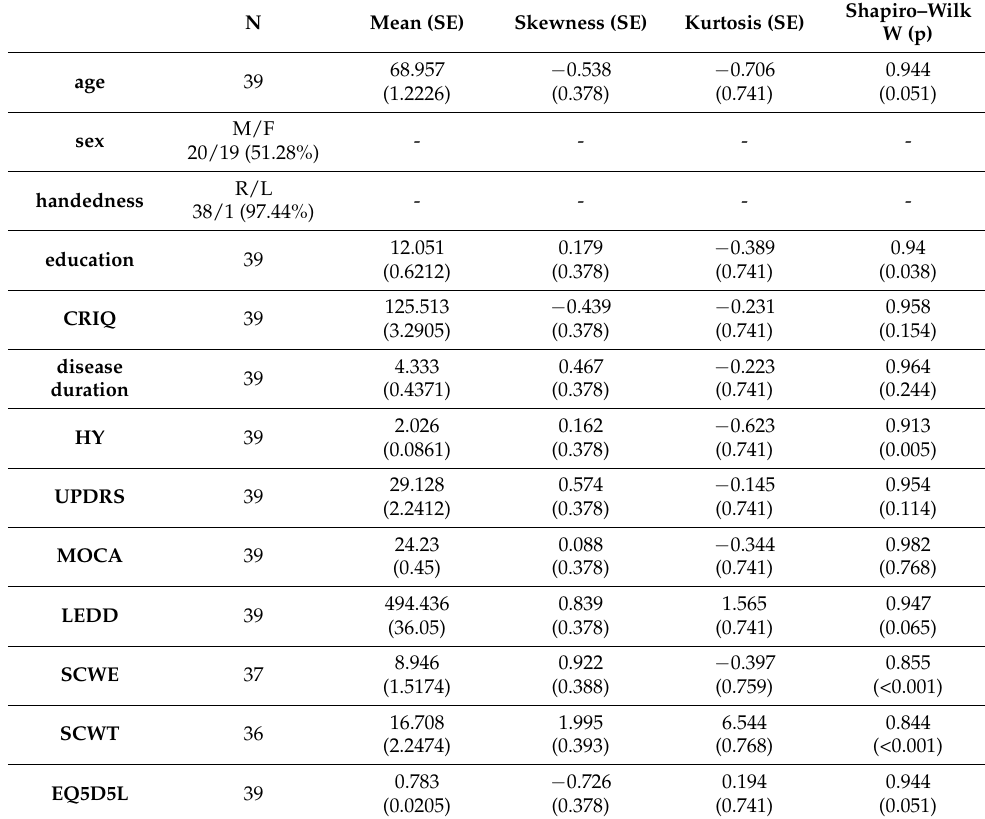
Table 6. Patients’ characteristics and clinical